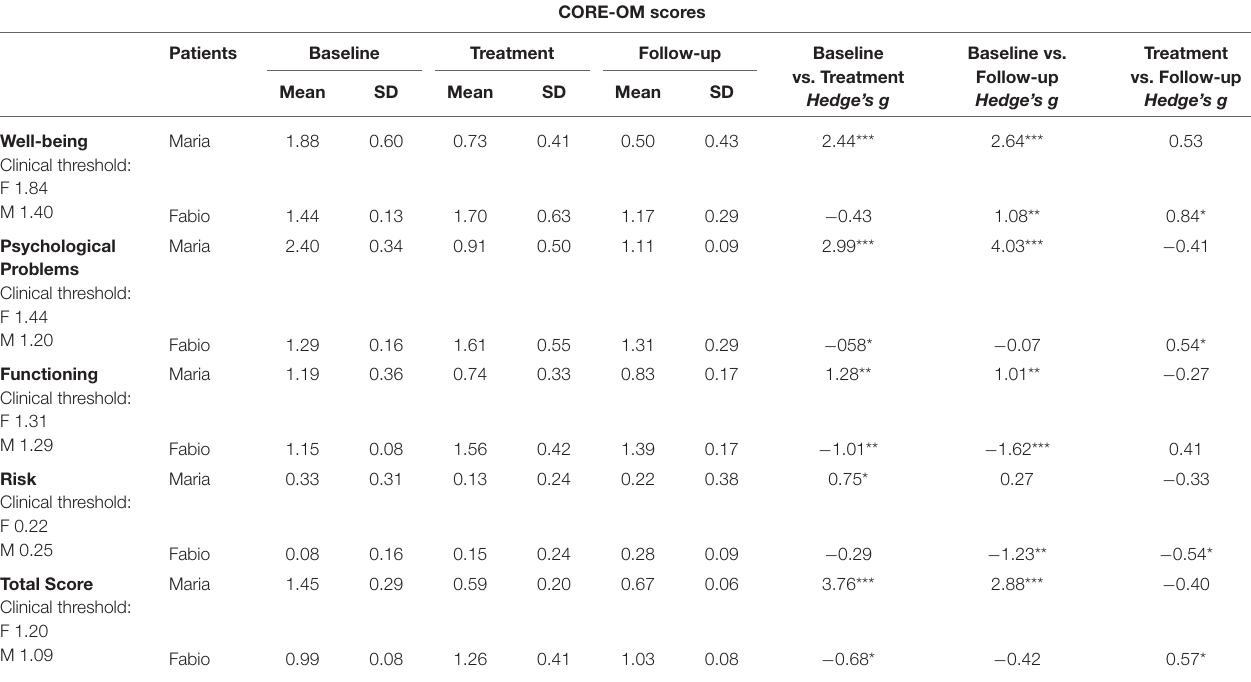
TABLE 1 | CORE-OM scores at baseline and treatment +